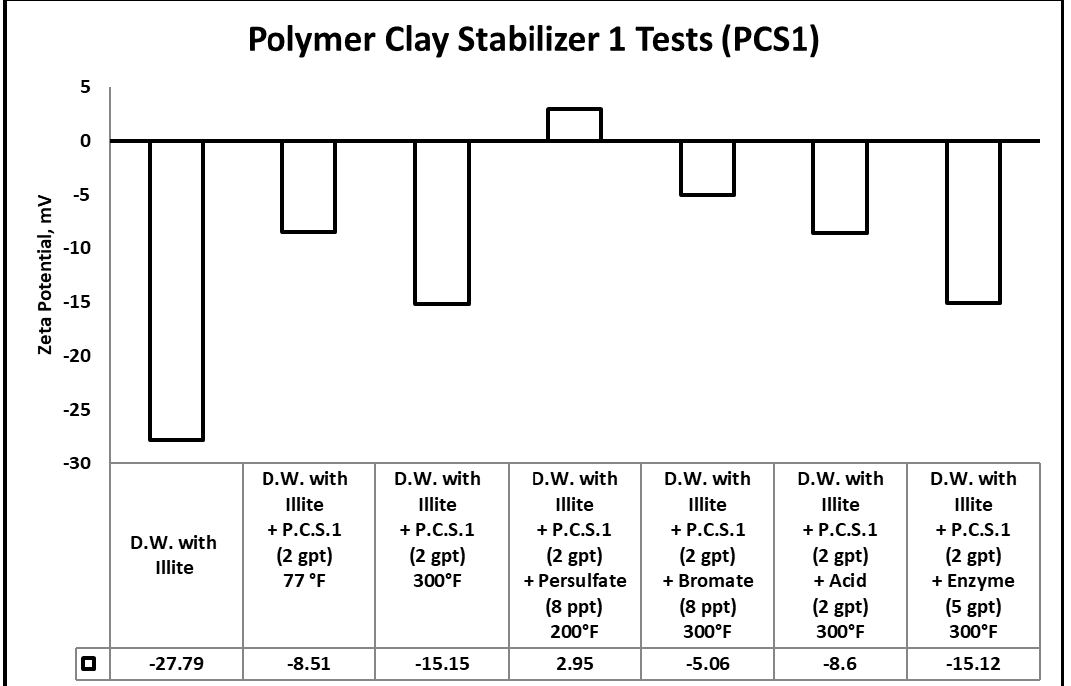
Figure 12. Zeta potential results for the tests involving gel breakers and polymeric clay stabilizer 1.